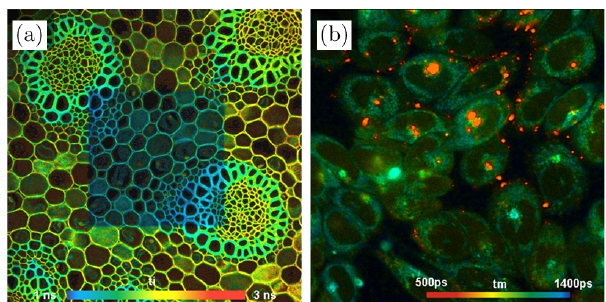
Fig. 1. Examples for illustrating photobleaching and photo- damage. (a) FLIM image of Convallaria , region in the center scanned with a 405 nm laser (10 7 photons per second) prior to imaging (10 6 photons per second). Photobleaching has changed the °uorescence lifetime in the pre-scanned area. (b) NADH FLIM image of live cells, two-photon excited (5 (cid:1) 10 5 photons per second). In the bright red spots, photodamage has occurred, revealing itself by an ultrafast decay component. With per- mission from Ref.